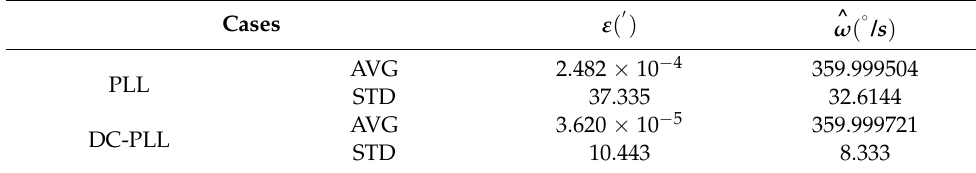
Table 4. The statistics of experiment demodulation